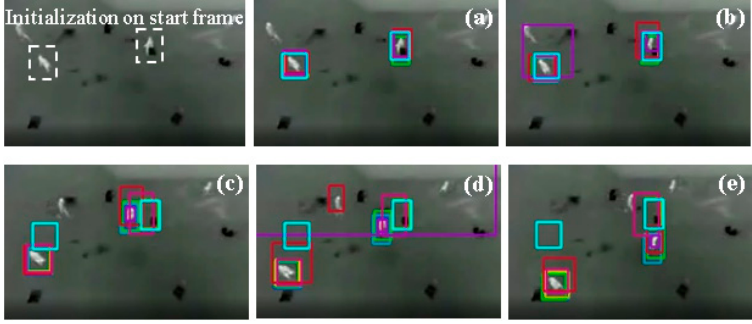
Figure 7. Processed frames as the time progresses (frames ( a – e )) during a multiple car (two objects) tracking process on the VIVID dataset.